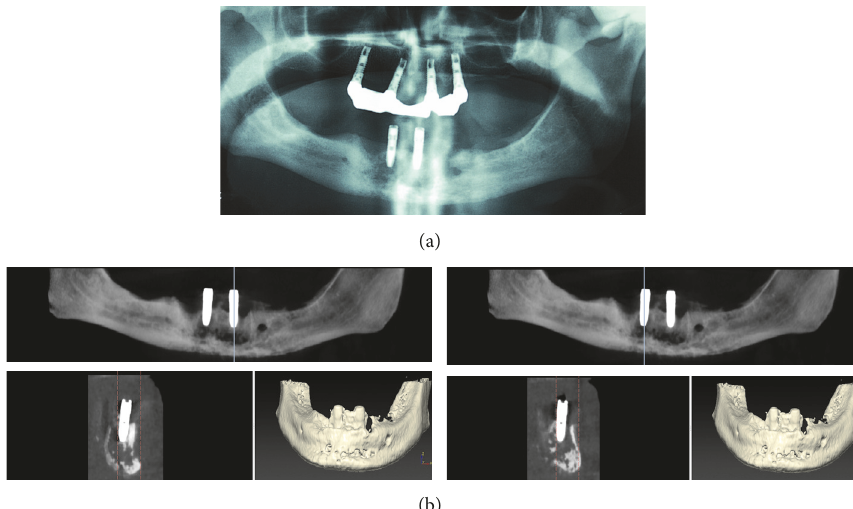
Figure 3: (a) Panoramic radiograph showing bone osteolytic lesions without defined borders after the second-stage surgery. (b) CBCT urgently performed showing osteolysis, with lingual and buccal cortical interruption.